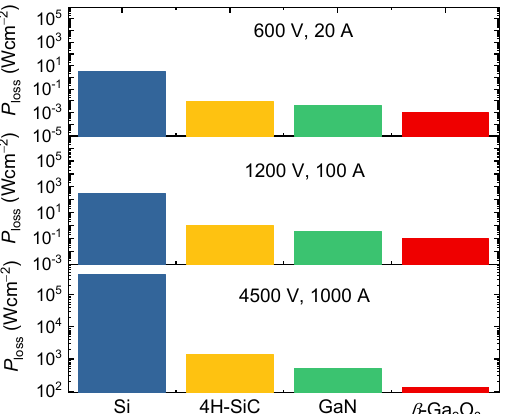
Figure 1. Comparison between the ideal power consumption of low ‐ doped drift region for various power devices with different voltage/current ratings.